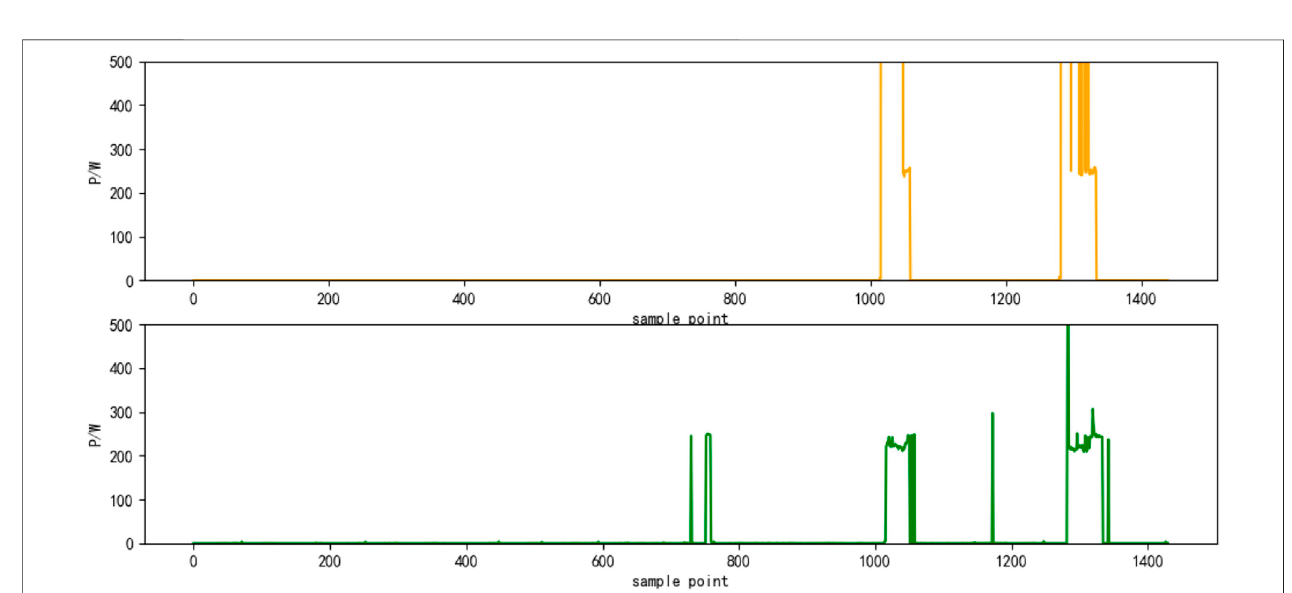
FIGURE 7 | Results of power decomposition (CWE).